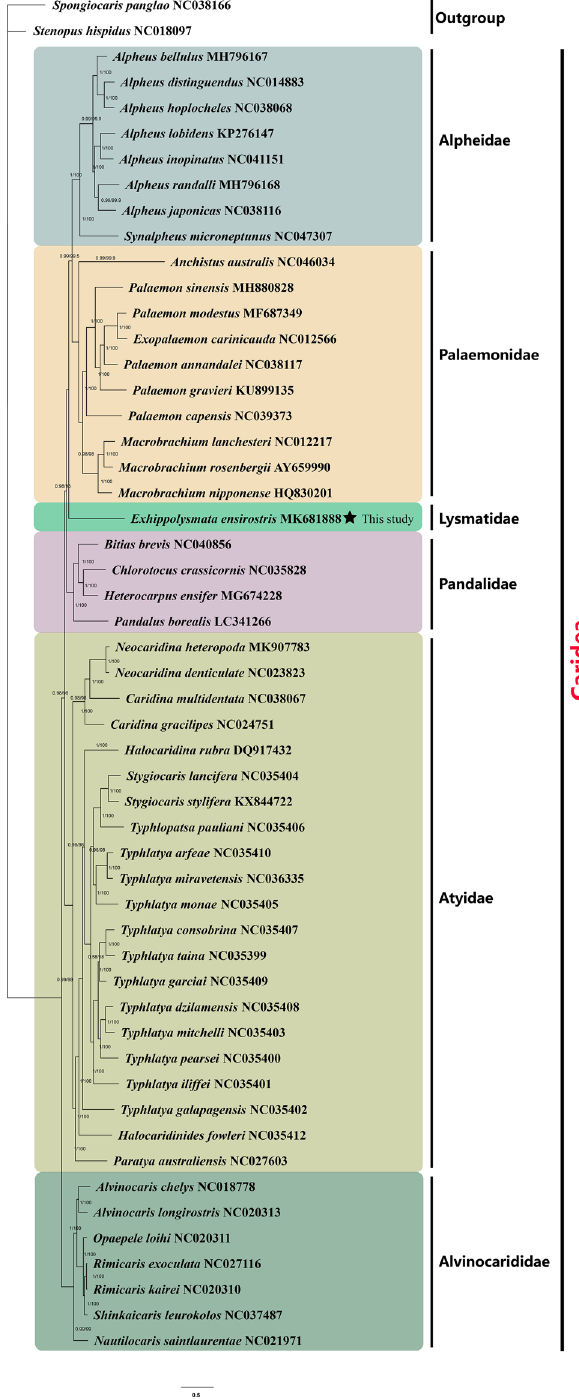
Figure 6. The phylogenetic tree was inferred from the nucleotide sequences of 13 mitogenome PCGs using BI and ML methods. Numbers on branches indicate posterior probability (BI) and bootstrap support